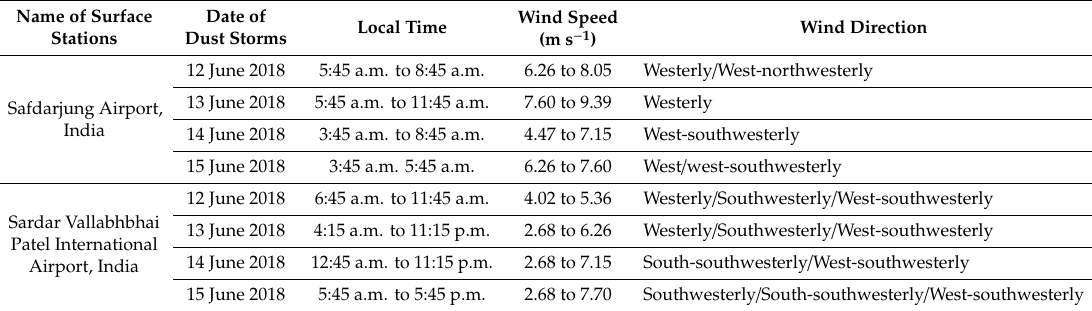
Figure 2. Observation of dust storms from some surface stations are shown by red coloured triangles in the map of regional overview of Indian subcontinent [24,25]. A triangle, which is shown in the side of Himalyas, represents Safdarjung Airport, India, and another triangle represents Sardar Vallabhbhai Patel International Airport, India. Rawinsonde sounding station at Ahamadabad in India is also shown by a yellow coloured star. Table 1. Surface weather data observed at two stations of India